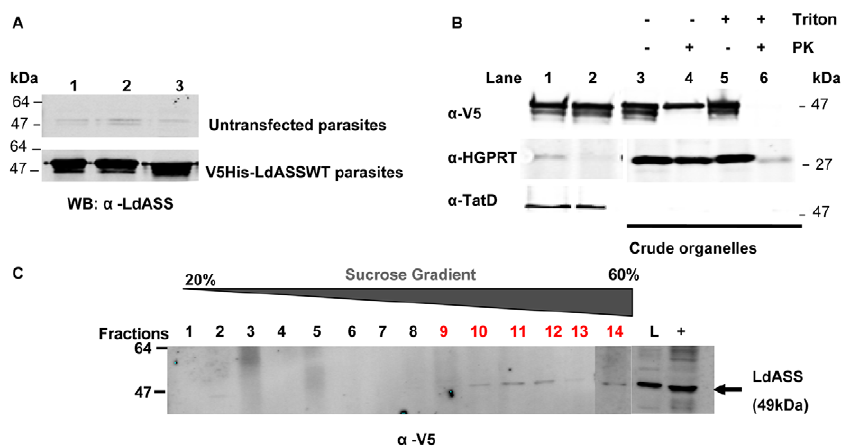
Figure 6. Subcellular organelle fractionation. (A) Cleared lysates (lane 1) from untransfected Ld1S2D parasites (upper panel) or V5-HisLdASS WT over expressing amastigotes (lower panel) were fractionated into cytosol (lane 2) and crude organelles (lane 3) and used for immuno-blot with anti- LdASS antibody. (B) V5-HisLdASS WT over expressing amastigotes were lysed then cleared (lane 1) and fractionated into cytosol (lane 2) and crude organelles (lanes 3–6). Crude organelles were treated with protease K in absence (lane 4) or presence of triton (lane 6). Proteins were separated by SDS page, transferred to nitrocellulose membranes, and then bound with anti-LdASS, anti-HGPRT and anti-TatD antibodies. (C) The crude organelle fraction of V5His-LdASS WT over expressing amastigotes was further fractionated on a linear 20–70% sucrose gradient. Sucrose fractions 1–21 were assayed for the presence of LdASS by Western blot analysis using anti-V5 antibody. Here only fractions 1–14 are shown on the membrane, L: crude organelle fraction layered on the gradient, + : cleared lysate as positive control.